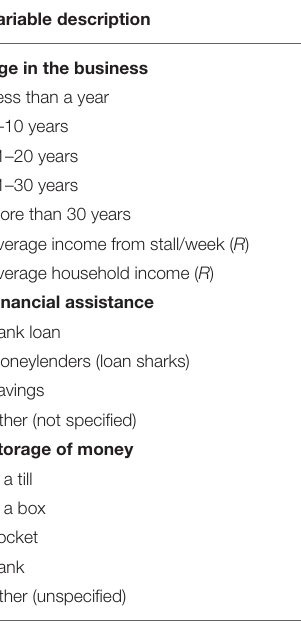
TABLE 2 | Business profile of the street food